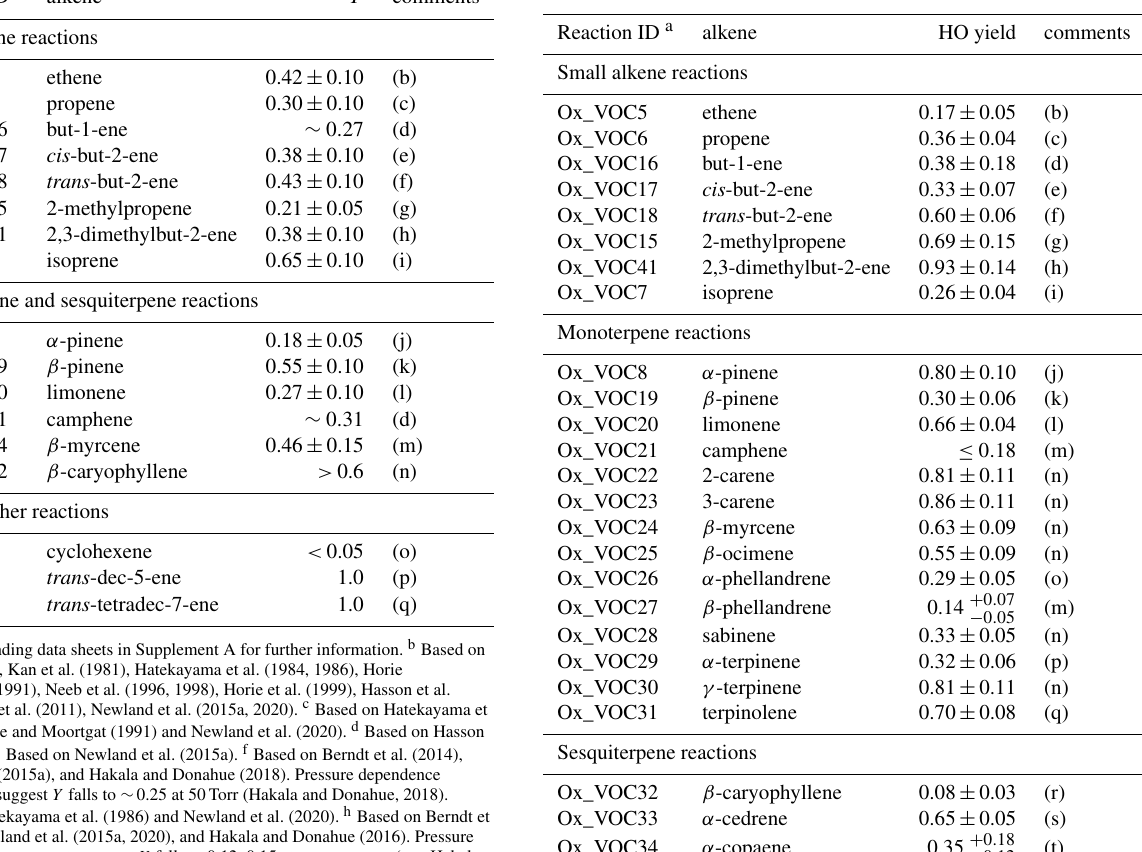
Table 3. Summary of recommended HO yields for reactions of O 3 with alkenes at 298K and